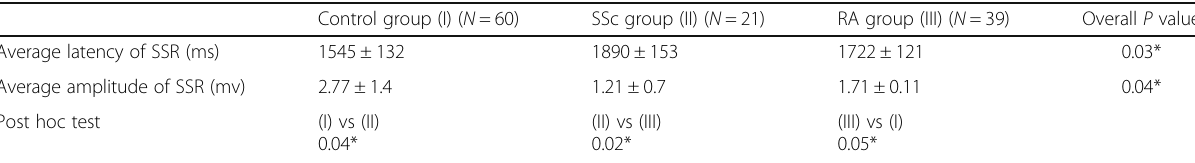
Table 3 Average values of SSR in the three groups (control group, SSc group, and RA